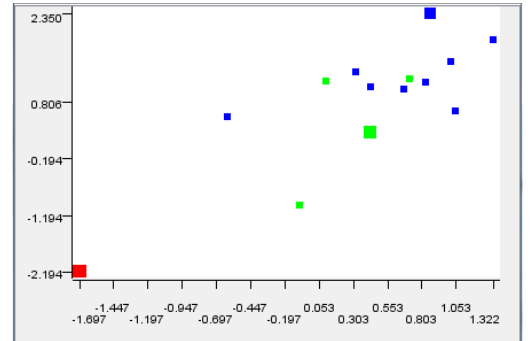
Fig. 11. The fuzzy rules induced from the Iris data projected on to a two dimensional space. Size represents coverage, color the class of the rule.